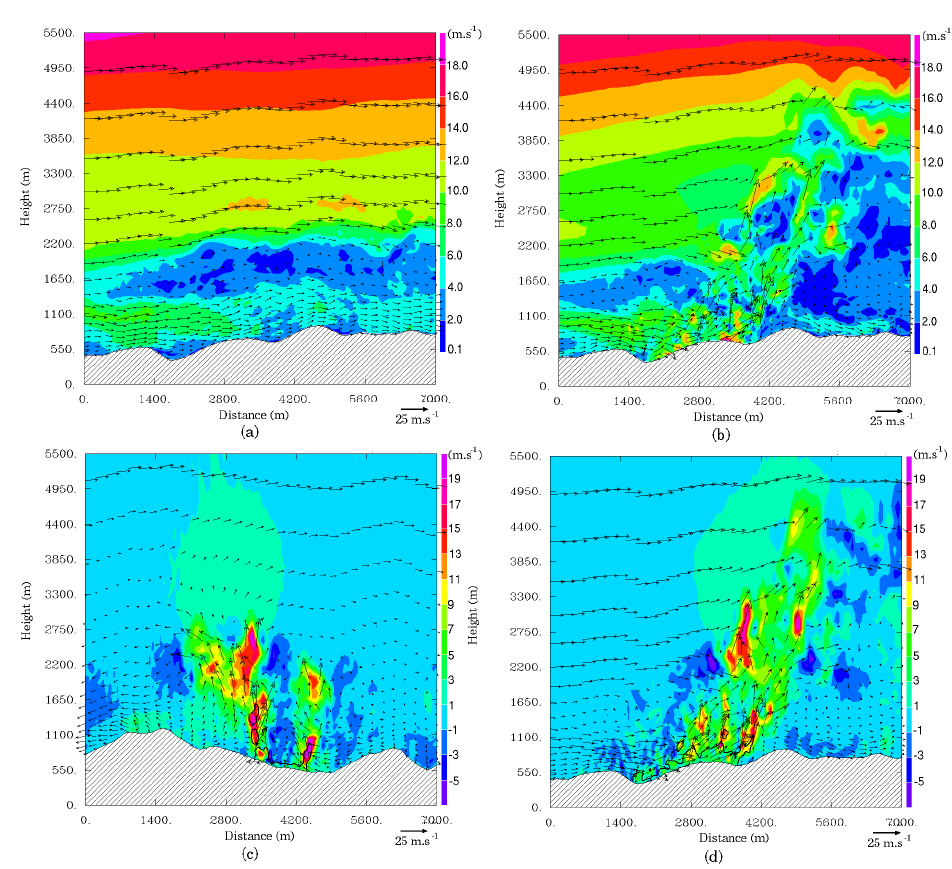
Figure 9. Vertical cross-sections on 23 July 2009 at 1500 UTC: ( a , b ) horizontal wind (in ms − 1 ) with wind vectors superimposed for ( a ) the “uncoupled” simulation and ( b ) the “coupled” one along the direction of propagation (axis (A) in Figure 8a); ( c , d ) vertical velocity difference between “coupled” and “uncoupled” simulations (in ms − 1 ) with the wind vectors (arrows) ( c ) across the fire front (axis (B)) and ( d ) along the direction of propagation (axis